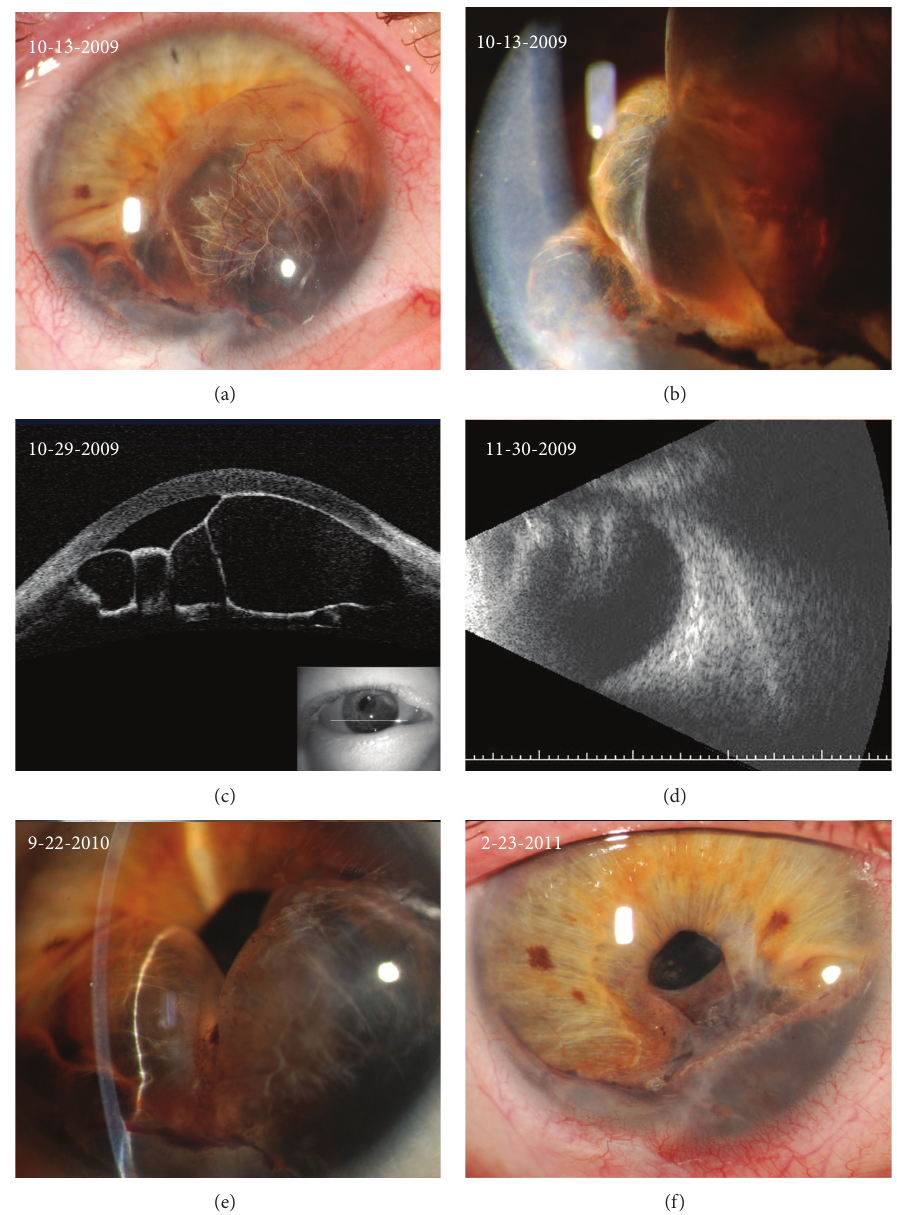
Figure 5: Clinical and diagnostic images from case 2. (a and b) Slit-lamp photographs illustrating multiple serous cysts emanating from the inferior iris, obscuring the pupillary opening, and apposing the corneal endothelium. Blood vessels and iris pigment can be seen along the cyst walls. The inferior cysts appear more opaque and homogenous as compared with the superior cysts. (c) AS-OCT showing 4 distinct cavities with low central reflectivity and highly reflective walls, confirming the fluid-filled nature of the iris cysts. The cysts can be seen abutting the corneal endothelium and normal iris architecture is disrupted. (d) B-scan ultrasound image confirming extension of the iris cysts into the vitreous cavity. (e) Slit-lamp photograph showing recurrence of multiple, serous iris cysts that once again appose the corneal endothelium and encroach upon the pupillary opening. (f) Slit-lamp photograph 1 year after cyst aspiration and second injection of 5-FU. There is complete regression of the cysts with residual iridocorneal